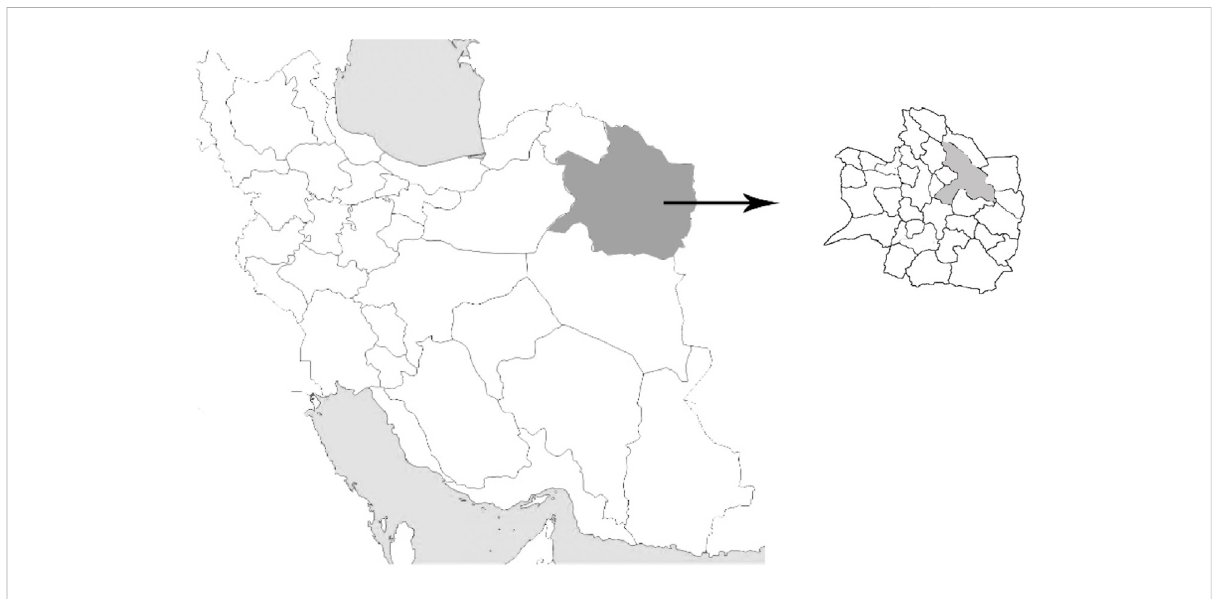
FIGURE 1 Map of